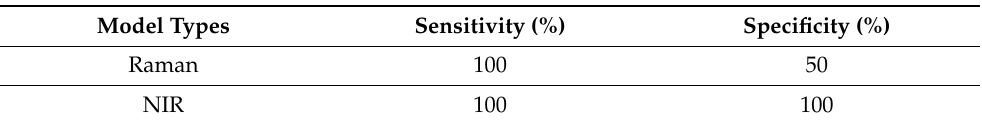
Figure 4. ( a ) Raman and ( b ) NIR SIMCA projection for the external validation set ( n = 16). ( c ) Information summary of manufacture’s label claims, GC-FID assignments, Raman SIMCA predictions and NIR SIMCA predictions for the external validation set. Table 3. Specificity and sensitivity values of SIMCA models obtained from the handheld Raman (1064 nm) and the miniature NIR spectral data.